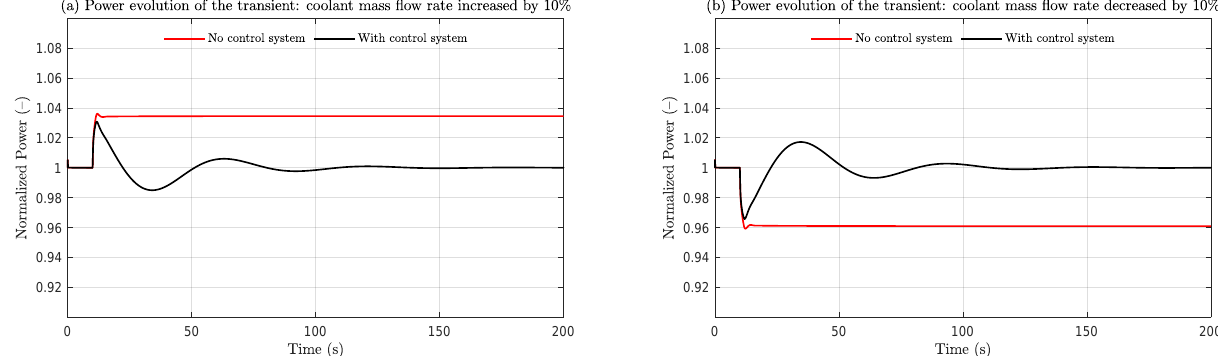
Figure 10. System response of the variation in the coolant mass flow rate: ( a ) coolant mass flow rate increased by 10%; ( b ) coolant mass flow rate decreased by 10%.